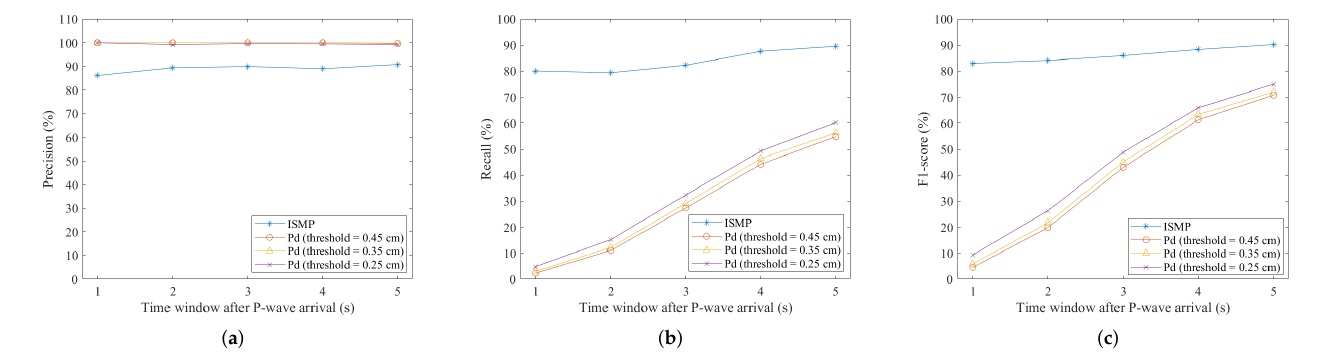
Figure 5. The training and validation process for the model using a three-second time window of the initial P-wave.